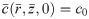
Results of first moment calculations for the first initial value problem of a fixed number of confined particles.Fig (a) is based on initial condition Eq (7) evaluated at t = 0, while results in (b) are based on the simpler state c¯(r¯,z¯,0)=c0 for x¯∈W0 and zero otherwise. Two different tube profiles are shown, both with the same throat radius, B = 0.2. Solid lines are for A = 0.24 (no recirculation), dashed lines are for A = 0.48 (recirculation). Results are displayed for β = 0, 100, 200, 300; Peclet numbers are pe = 0, 1000, 2000, 3000 as indicated by arrows. In (b), results for the A = 0.24 tube (solid lines) are all but indistinguishable on the scale of the figure. The dependence on β is indicated by the arrow. In all cases, simulations were performed with α = 0.1 and ΔPa(t). The physical significance of positive and negative values of the first moment are schematically represented by the insets to Figs 3(a) and 7(a), respectively.